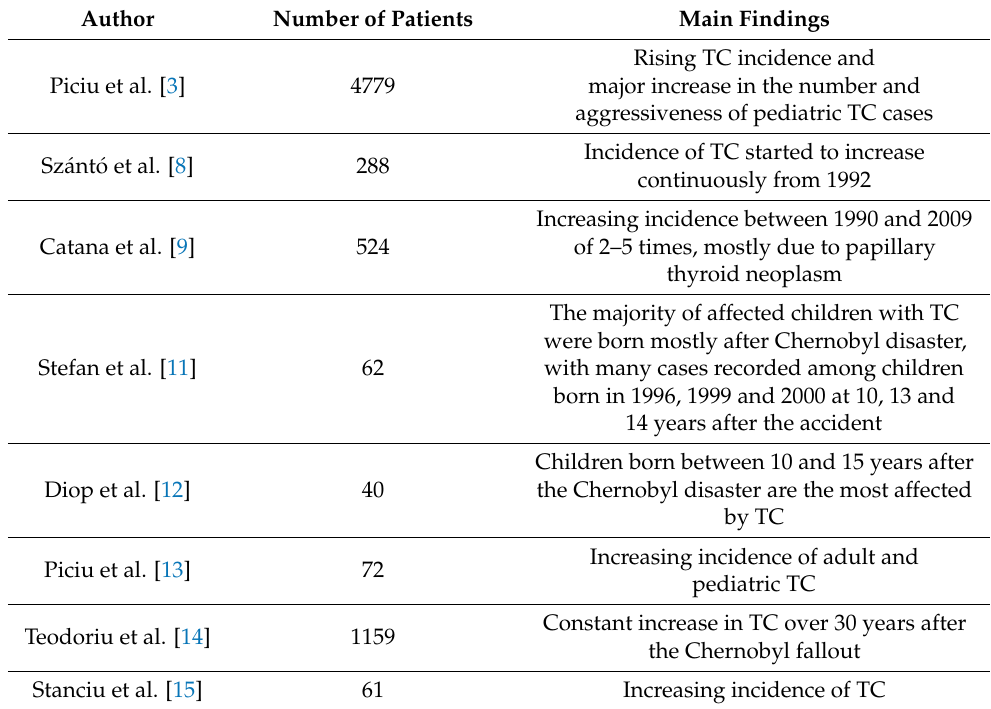
Table 4. Main finding from the case studies radiation induced thyroid carcinoma in Romania due to the Chernobyl nuclear fallout.